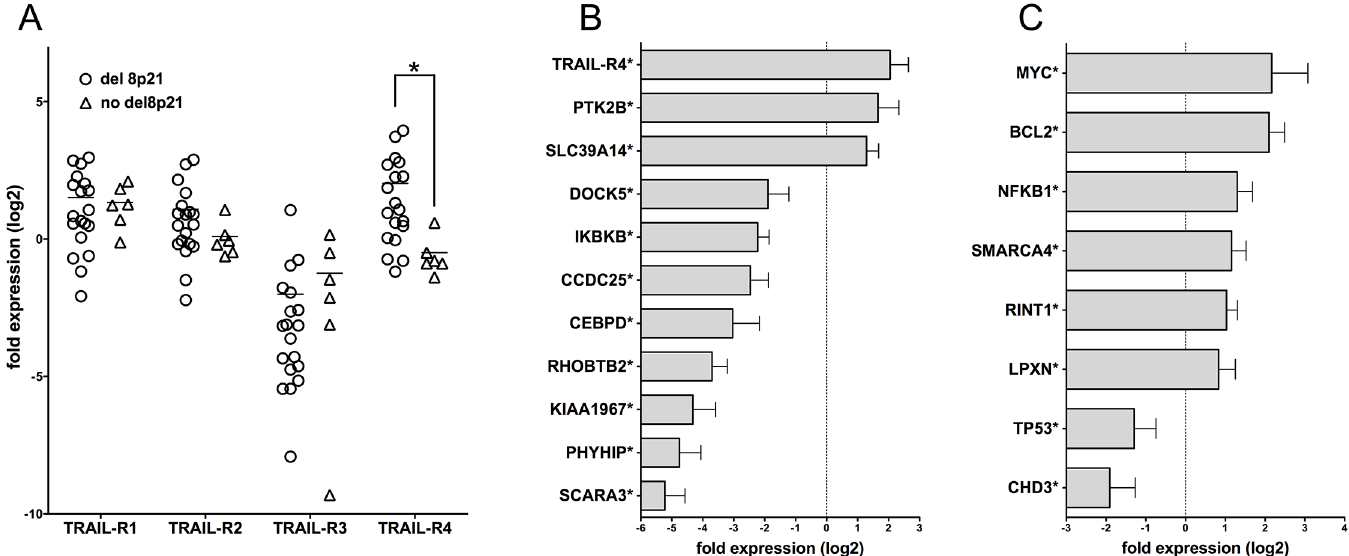
Fig 2. Quantitative RT-PCR analysis of gene expression in MM patients with or without del(8)(p21). TLDA cards were used to analyze mRNA levels in patients with (n = 19) and without (n = 6) del(8)(p21). For the analysis, GAPDH and ACTB genes were used as endogenous controls while RNA samples from K562 and U266 cell lines were used as calibrators. ( * p < 0.05, unpaired t test) (A) The mRNA level relative expression of TRAIL receptors in patients with and without the deletion. TRAIL-R1,-R2 and – R3 did not show any change while TRAIL-R4 was expressed at significantly higher levels in patients carrying the deletion. (B) Genes on or near 8p21 (C) other analyzed genes located elsewhere in the chromosome that show at least two-fold differential expression in MM cells with the deletion. Depicted are the gene expression levels in MM cells carrying the deletion, normalized to samples without the deletion.